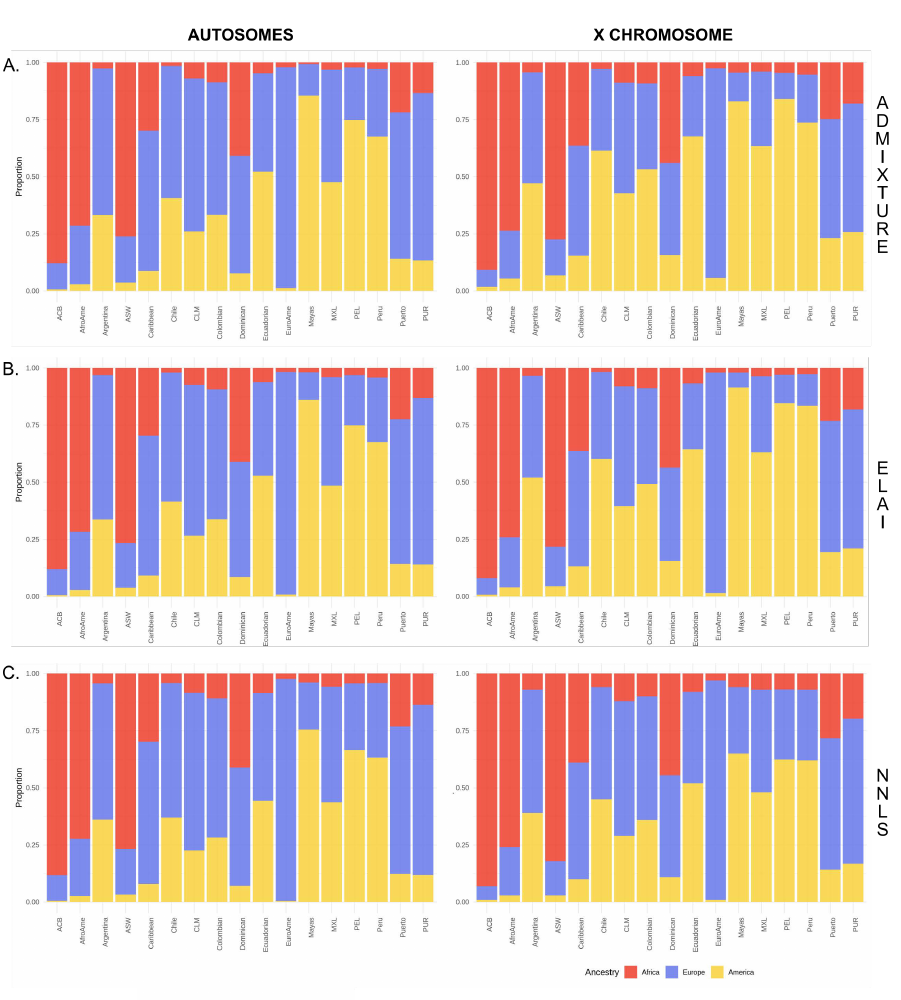
Figure 1. Overview of autosomal and chromosome X global continental proportions in admixed American populations inferred with three different methods: ( A ) ADMIXTURE, ( B ) ELAI and ( C )